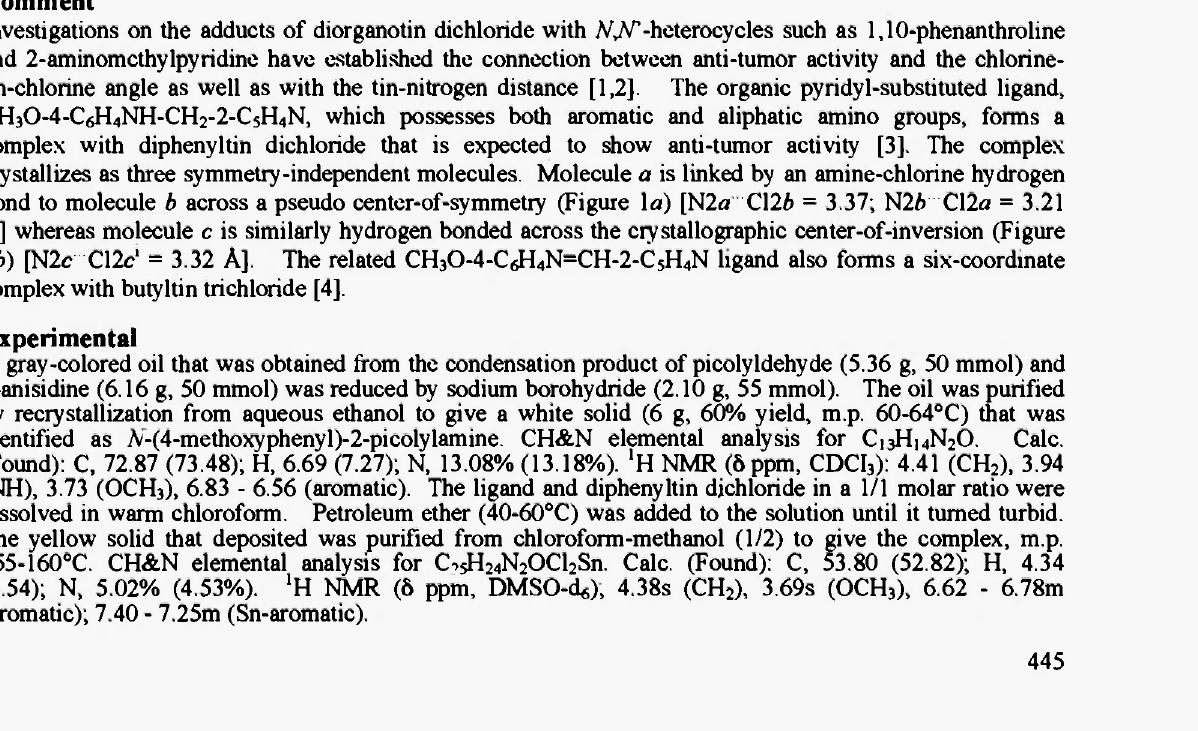
Figure Ια. ΟΚΓΕΡ plot of the hydrogen-bonded a and Figure 14 ORTEP plot of the c molecule as a b molecules at the 30% probability level. hydrogen-bonded dimer at the 30% probability